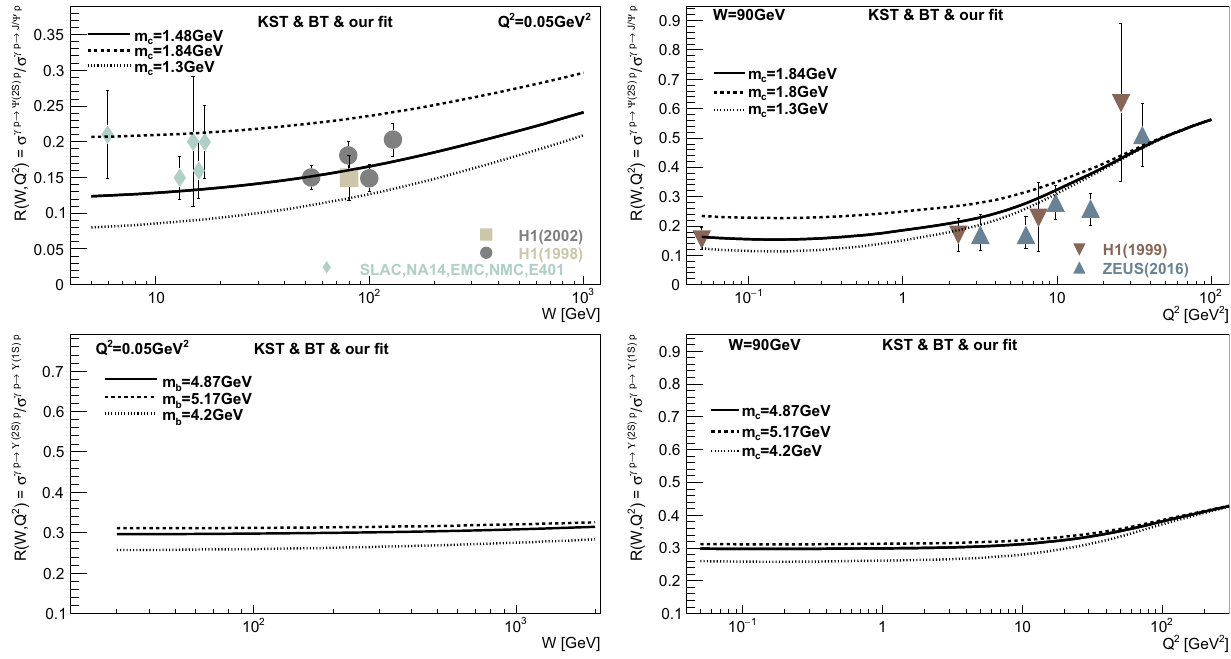
Fig. 23 The same as Fig. 21 but for the test of sensitivity of the dipole model model predictions to the charm m c and bottom m b quark mass variations the scaling variable Q 2 + M 2 lead to a similar onset of vari- tion of bottomonia (see also Ref. [9]) at the corresponding V ous effects in production of different quarkonia, we predict a photon virtuality Q 2 (ϒ) ≈ Q 2 ( J /ψ) + M 2 the bottom panels of Fig. weak onset of spin effects also in photo- and electroproduc-